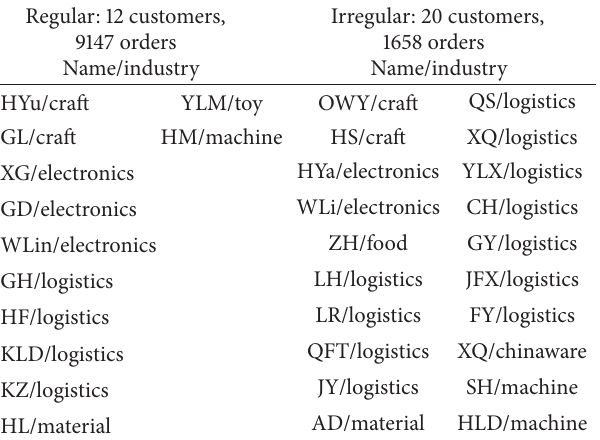
Table 2: Regular and irregular